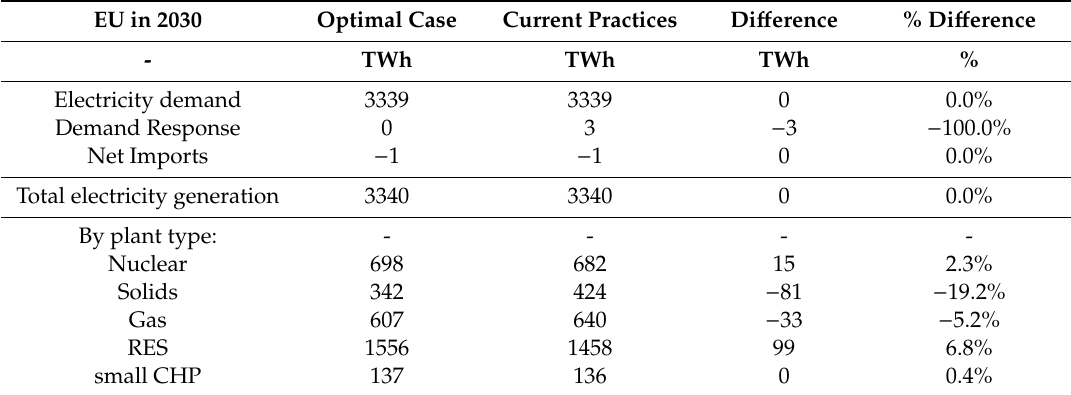
Table 7. Generation by plant type in the day-ahead market.